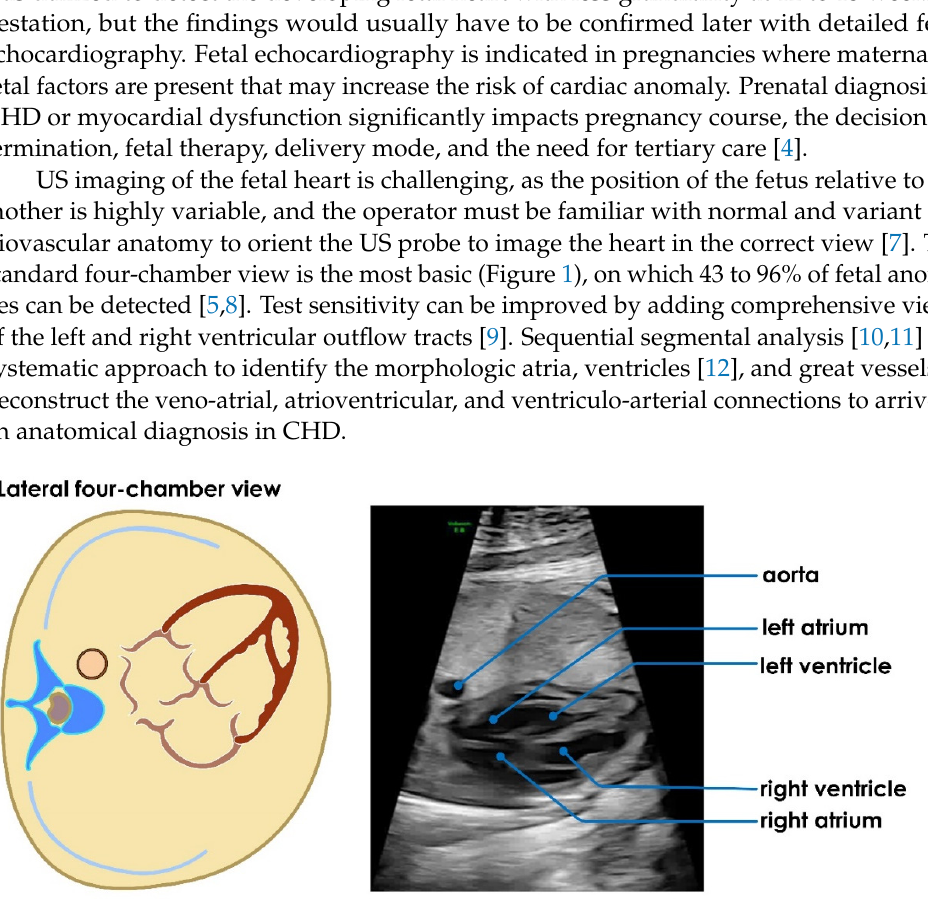
Figure 1. Standard four-chamber view showing normal appearance and spatial relationships of the four heart chambers and aorta. This image was acquired from the subcostal window with an ultrasound beam perpendicular to the interventricular septum. A similar image can be acquired from the cardiac apex; in which case, the ultrasound beam would be parallel to the interventricular septum. In addition to cardiac structure, fetal echocardiography allows for the assessment of heart function, including the quantification of chamber dimensions and ventricular ejection fraction. However, the latter is load-dependent and may not represent